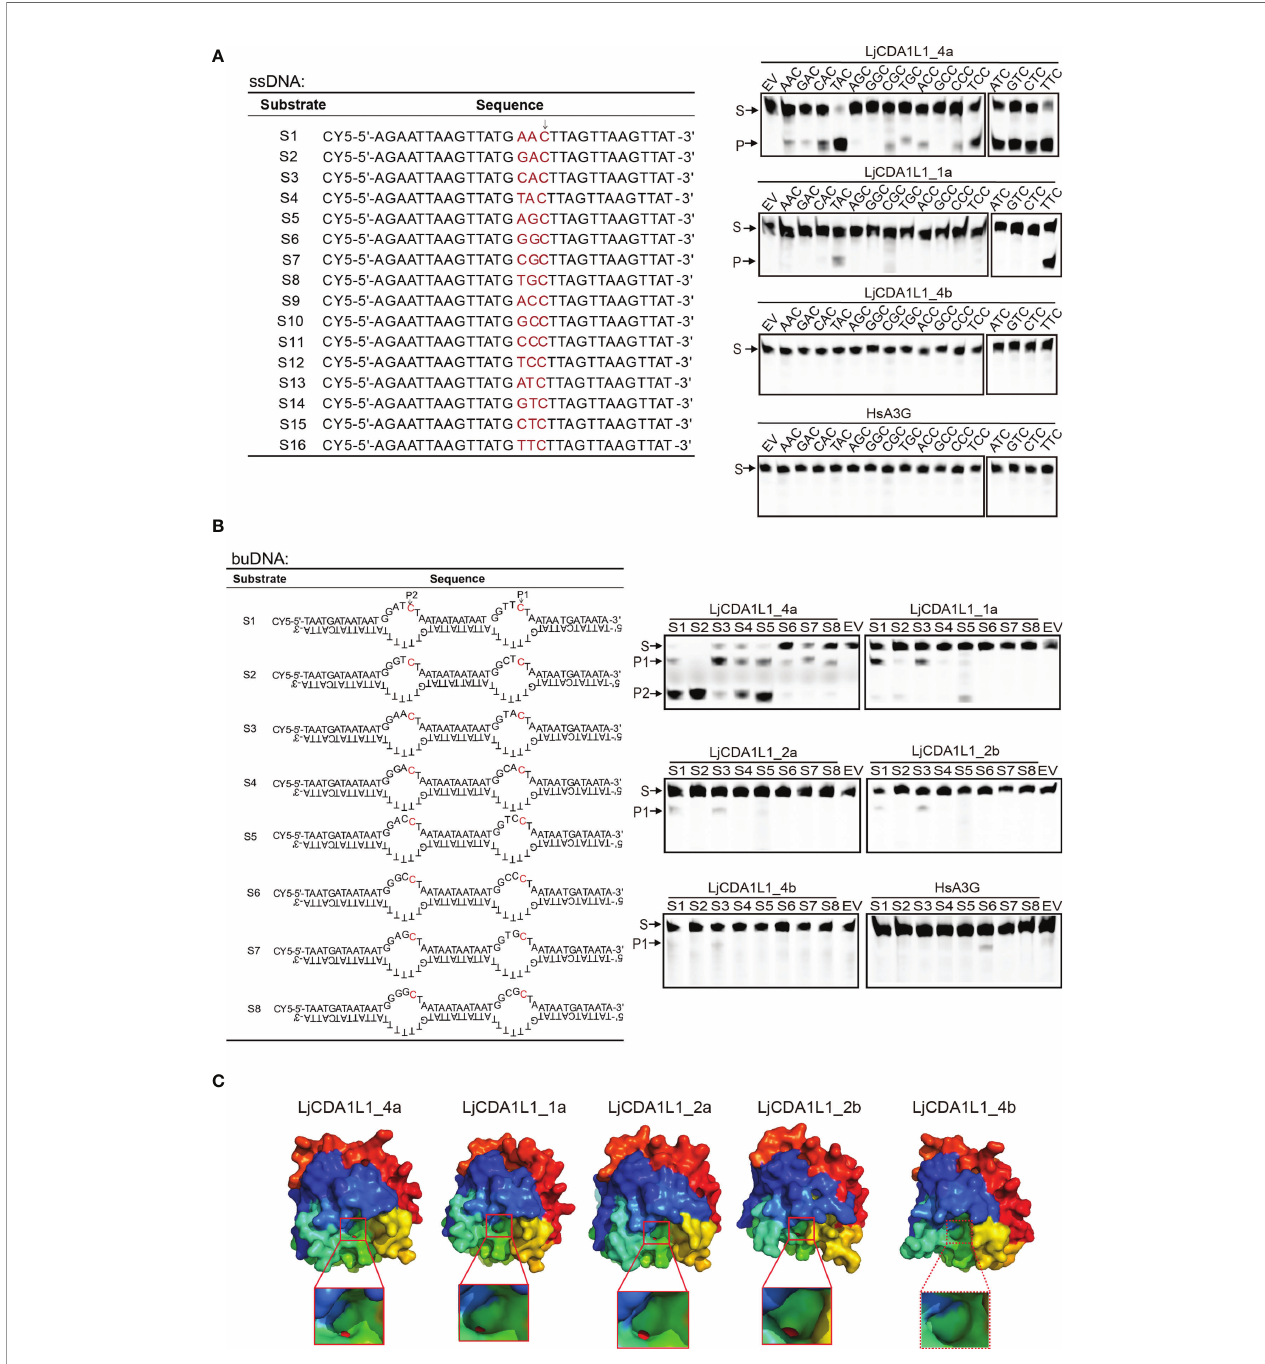
FIGURE 4 | Cytidine deaminase activity of LjAID/APOBEC on single-stranded DNA (ssDNA) and bubble DNA (buDNA) in vitro . (A) Cytidine deaminase activity of LjAID/APOBEC on ssDNA in vitro . The table indicates the used ssDNA substrates labeled with CY5. WCLs of LjAID/APOBEC expressing 293T cells were used to test the enzyme activity. Arrow represents the target C. S, substrate; P, product; EV, empty vector. (B) Cytidine deaminase activity of LjAID/APOBEC on buDNA in vitro . The table indicates the used buDNA substrates labeled with CY5. WCLs of LjAID/APOBEC expressing 293T cells were used to test the enzyme activity. Arrows represent the target C. S, substrate; P, product; EV, empty vector. (C) The predicted crystal structures of LjCDA1L1_4a, LjCDA1L1_1a, LjCDA1L1_2a, LjCDA1L1_2b, and LjCDA1L1_4b using the SWISS-MODEL. Red boxes represent the “ pocket. ” Red spheres represent zinc ions. All results were representative of three independent biological